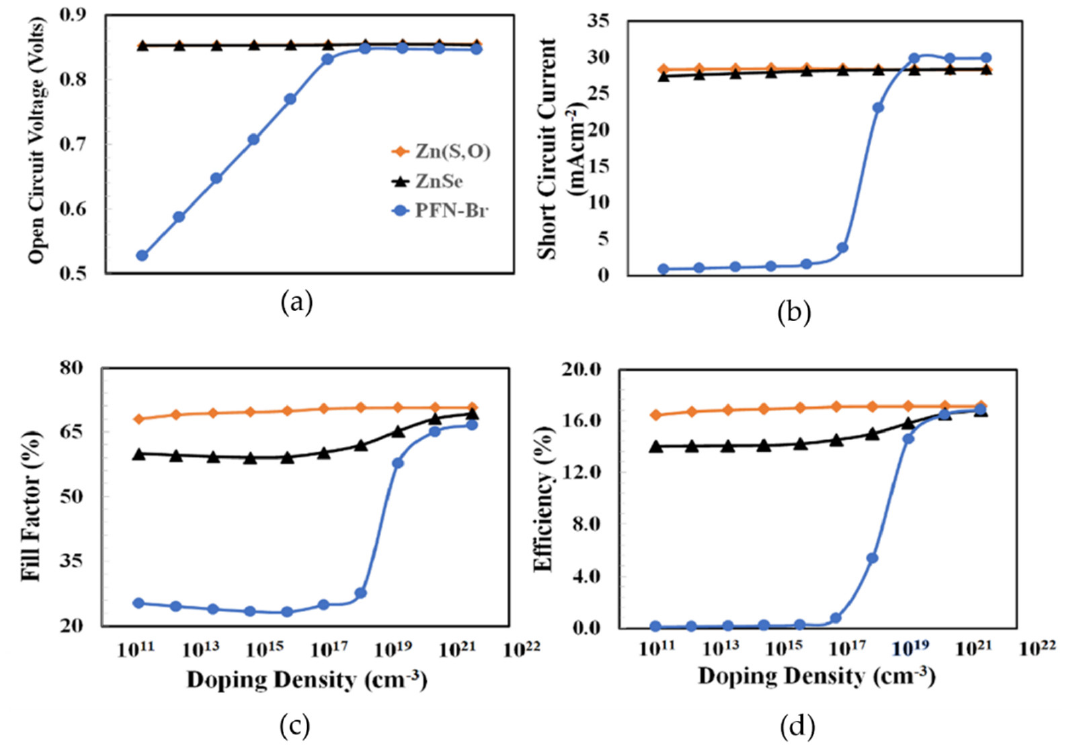
Figure 6. The photovoltaic parameters of ( a ) open-circuit voltage, ( b ) short-circuit current, ( c ) fill factor, and ( d ) power conversion efficiency as a function of the electron transport layer (Zn(O,S), ZnSe, PFN-Br) doping density for ITO/Zn(O,S)/PTB7:PC 70 BM/PEDOT:PSS/Au, ITO/ZnSe/PTB7:PC 70 BM/PEDOT:PSS/Au, ITO/PFN-Br/PTB7:PC 70 BM/PEDOT:PSS/Au, respectively.